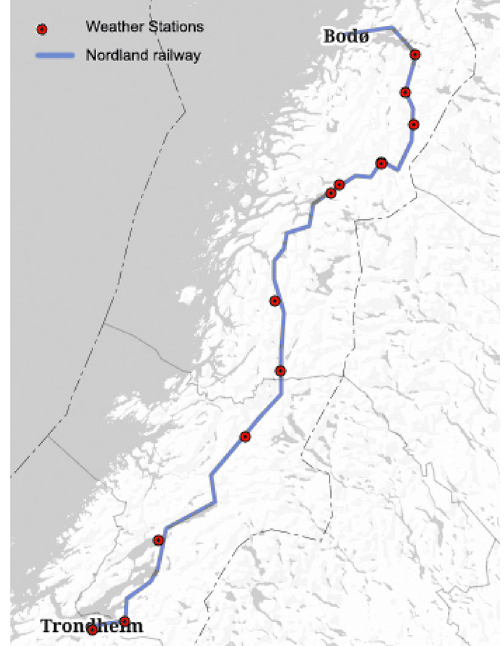
Fig. 3 Nordland railway line and weather stations selected for the main analysis (Source for map: Google Maps, www.google.com/ maps)